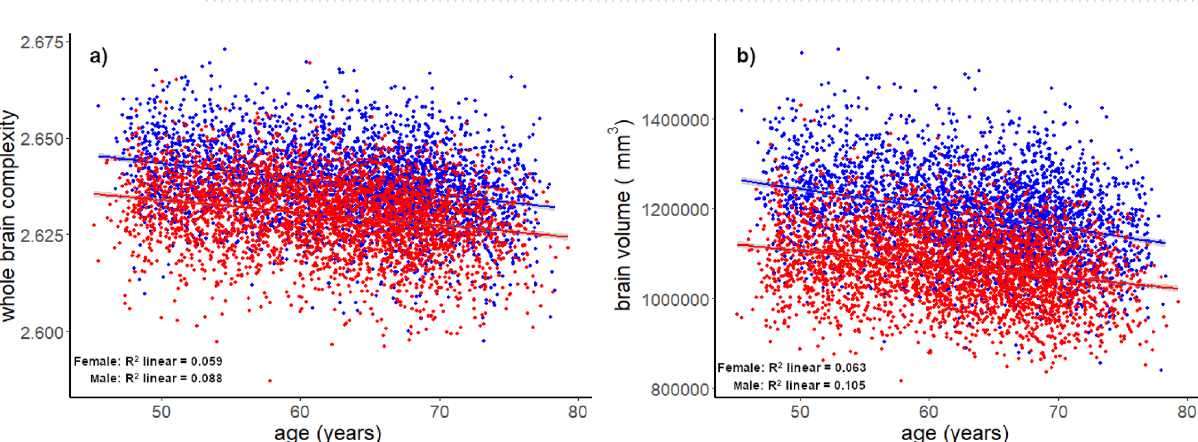
Figure 3. UK Biobank—correlation between whole brain complexity ( a ), volume mm 3 ( b ) and age (45–79 y) for women (red) and men